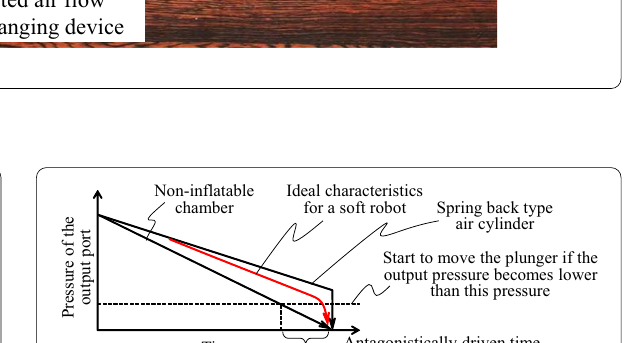
Self-excited air flow passage changing device